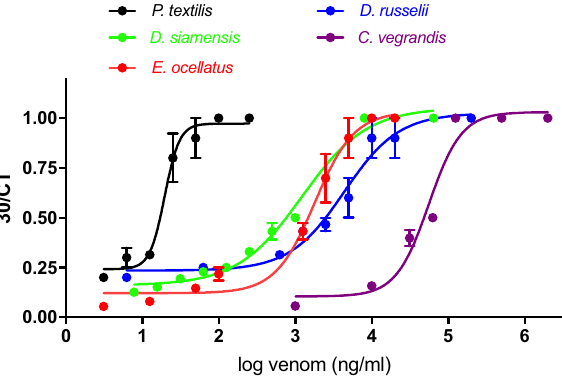
Figure 3. The pro-coagulant effects of venoms on the clotting time of fresh frozen plasma (n = 5–6).